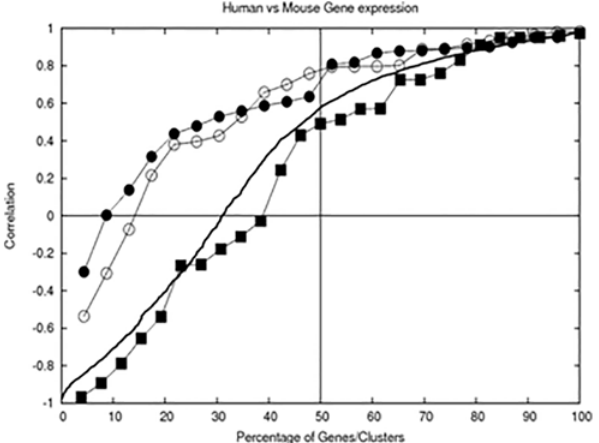
Fig 4. Correlation of profiles of gene groups/clusters and individual gene pairs, sorted and drawn as a function of percentage of total number of group/gene pairs. The bold line shows a correlation of expression profiles of the same gene in human vs in mouse. Correlation of average profiles of gene groups are also shown: line with filled circles -clustered using mESC gene expression profiles, line with open circles — clustered using hESC profiles, line with filled squares — co-clustered. The correlations were sorted and drawn as a function of percentage of all group/gene pairs, allowing comparison of cases with different number of pairs. Significance of correlation p < 0.05 is at correlation coefficient larger than 0.67 for 9-point expression profiles and 0.71 for 8-point profiles.